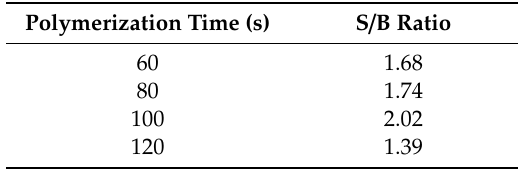
Figure 8. The SEM images of ( a ) MOF525 / PEpC; ( b ) high-resolution MOF525 / PEpC; and ( c ) the CV traces of unmodified and PEpC-based microelectrodes. Table 2. E ff ect of PEpC polymerization time on the S / B